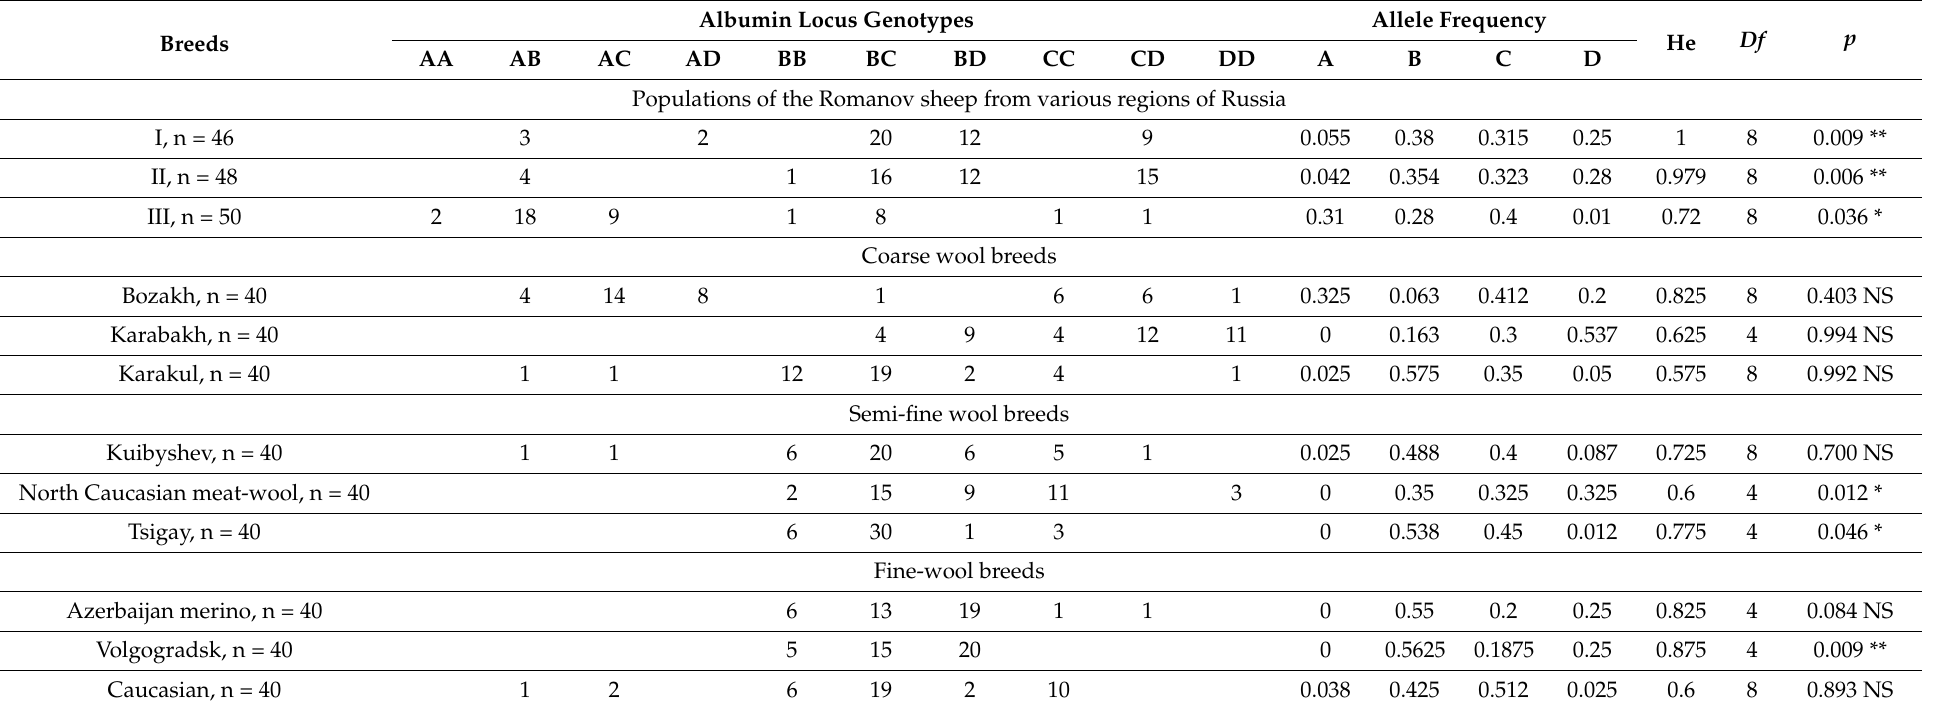
Table 7. Polymorphism of the albumin ( ALB ) locus in various breeds of sheep (n = 504). Albumin Locus Breeds